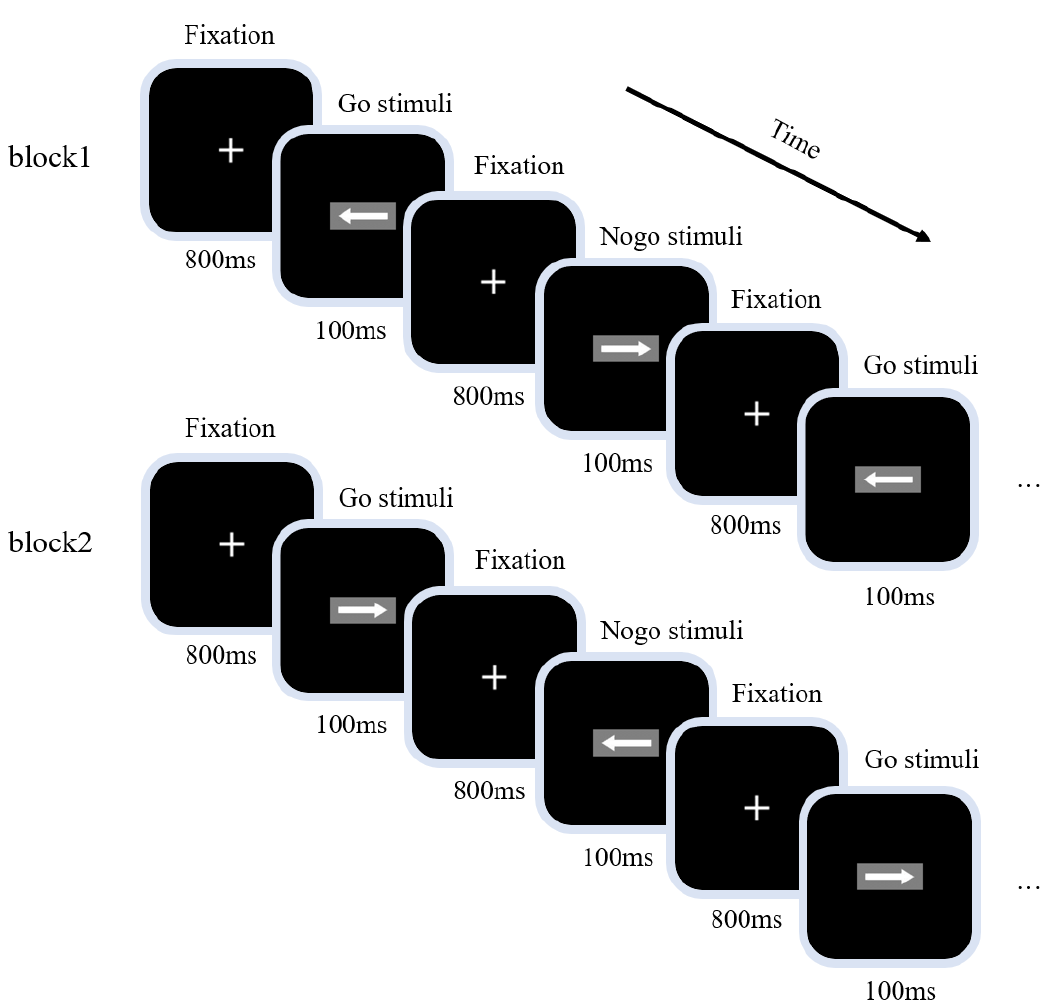
Figure 1. Visual Go/NoGo task diagram. The task was divided into two blocks, each containing 200 trials. Go and NoGo stimuli accounted for 2/3 and 1/3 of all stimuli, respectively; the presentation time of each stimulus was 100 ms and the interval between two adjacent stimuli was 800 ms.